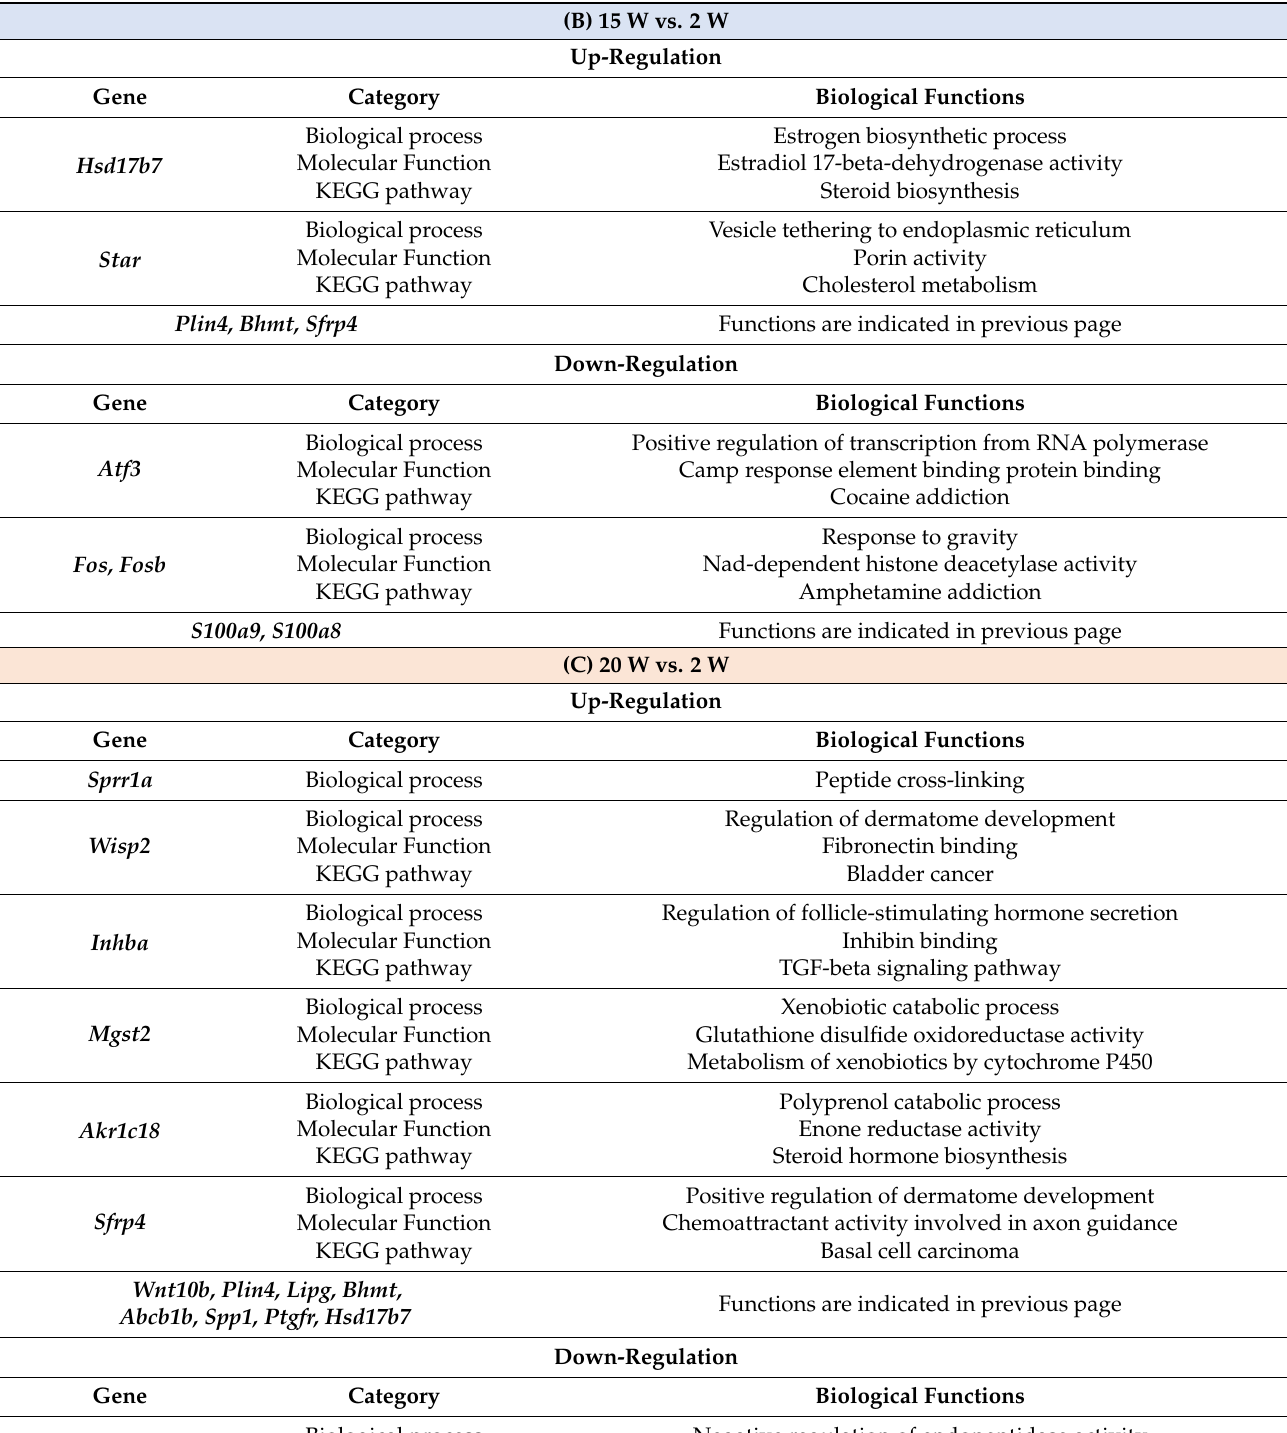
Table 3. Cont. (B) 15 W vs. 2